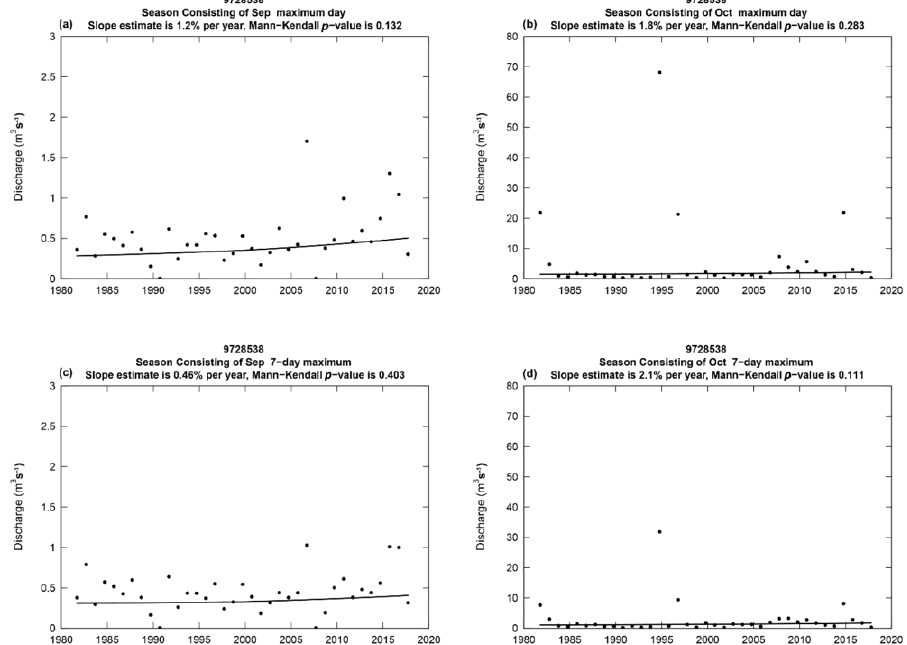
Figure A3. Trends of maximum 1-day and 7-day average discharges in the MREMA sub-basin during the period 1981 – 2017 for September ( a , c ) and October ( b , d ), respectively. A Thiel-Sen slope and a two-sided p-value for the Mann-Kendall trend test are also presented in the graphs.